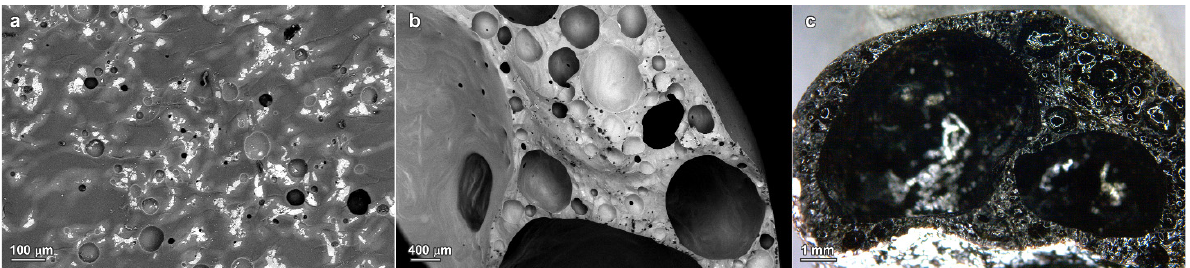
Figure 5. Microstructural details of selected glass ceramics ( a ) 25 wt% S1, 1000 °C;